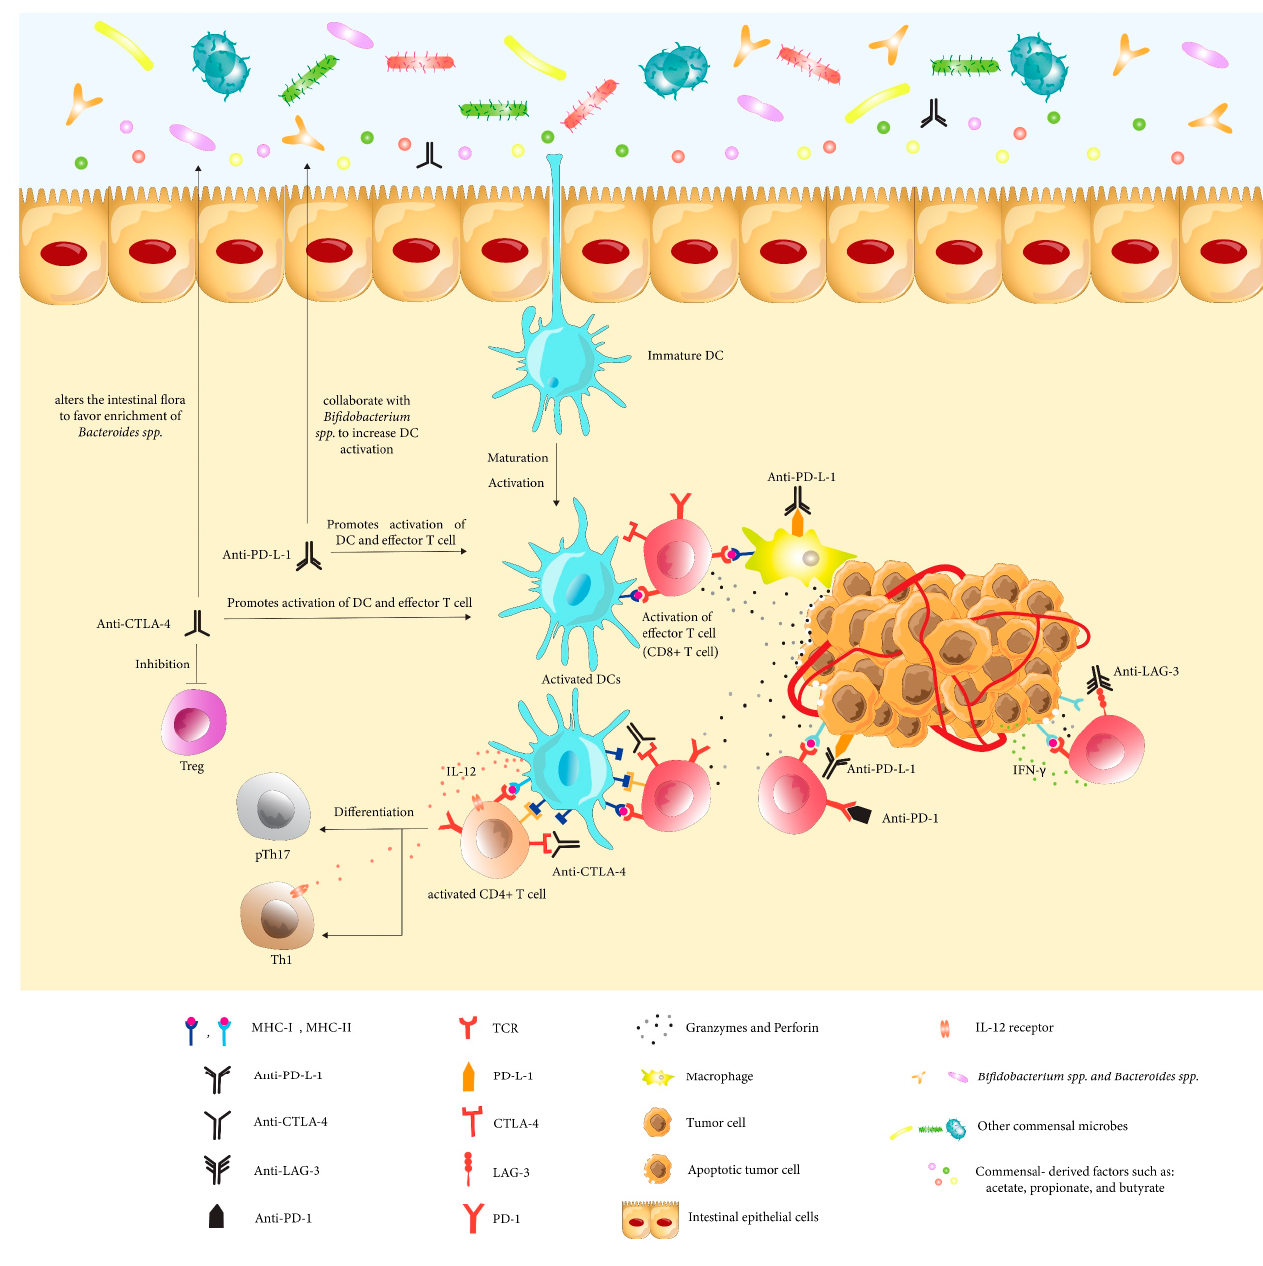
Figure 1. Association between Immunotherapy and Microbiome. Microbiome components (specific Bacteroides spp and Burkholderiales) such as short-chain fatty acids (SCFAs), mainly acetate propionate and butyrate, improve the efficiency of CTLA-4 blockade by promoting tumor control through stimulating Th1 immune responses during anti-CTLA-4 therapies. Anti-CTLA-4 indirectly modifies the gut flora to promote Bacteroides species enrichment, possibly by enhancing epithelial barrier breakdown. Consequently, these enriched species boost the activation and maturation of dendritic cells (DCs), which provide tumor antigens to enhance the recruitment and activity of T lymphocytes, inducing pTh17 and Th1 differentiation. In addition, anti-CTLA-4 blocks the immunosuppressive function of regulatory T cells (Tregs). Anti-PD-L1 treatment depends on the presence of important genera in the host, specifically Bifidobacterium, which promotes DCs activation and antitumor T cell responses. These processes spread systemically and suppress cancer cells through augmenting Th1 and CD8+ T cells and upregulating IFN- γ and Granzyme B while on anti-CTLA-4 and anti-PD-1/PD-L1 therapy.